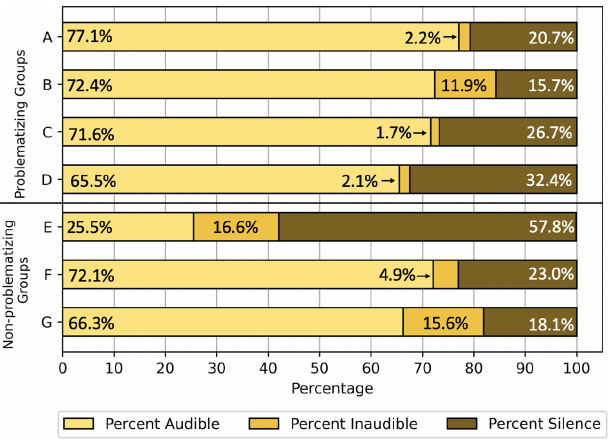
FIG. 4. Percent of time spent working in groups that was audible and inaudible speech and silence. Group E spends the majority of their time in silence, while all other groups spend the majority of their time in discussions audible on recordings.